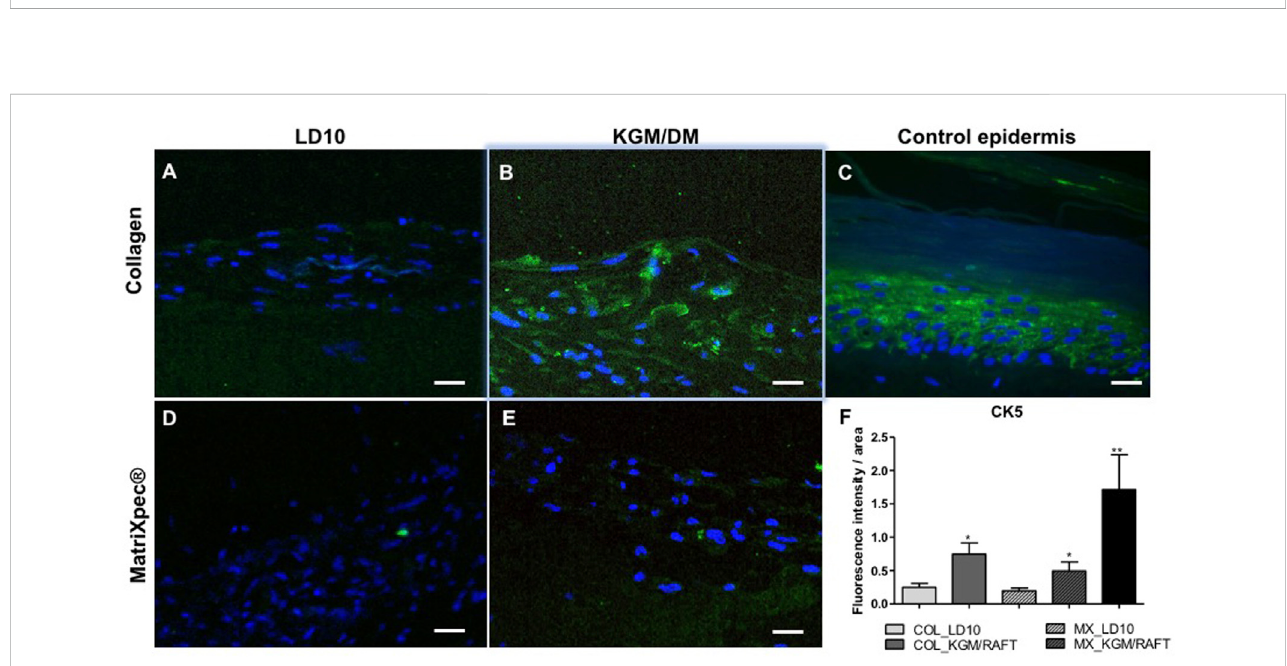
FIGURE 4 Expression of e-cadherin and vimentin. (A) E-cadherin and (B) Vimentin. MSCs were cultivated with LD10 or KGM/DM, during 4, 7, and 10 days onto collagen. MSC cultured in 2D was the negative control, and control skin was the positive control. Data was normalized by the expression of the constitutive gene GAPDH and analyzed in relation to MSCs used as epidermal equivalent and cultivated with LD10 on the fourth day of exposure to ALI. * ( p < .05), *** ( p < .001) different in comparison to MSC cultivated with LD10 at day 4; ns: not signi fi cant.